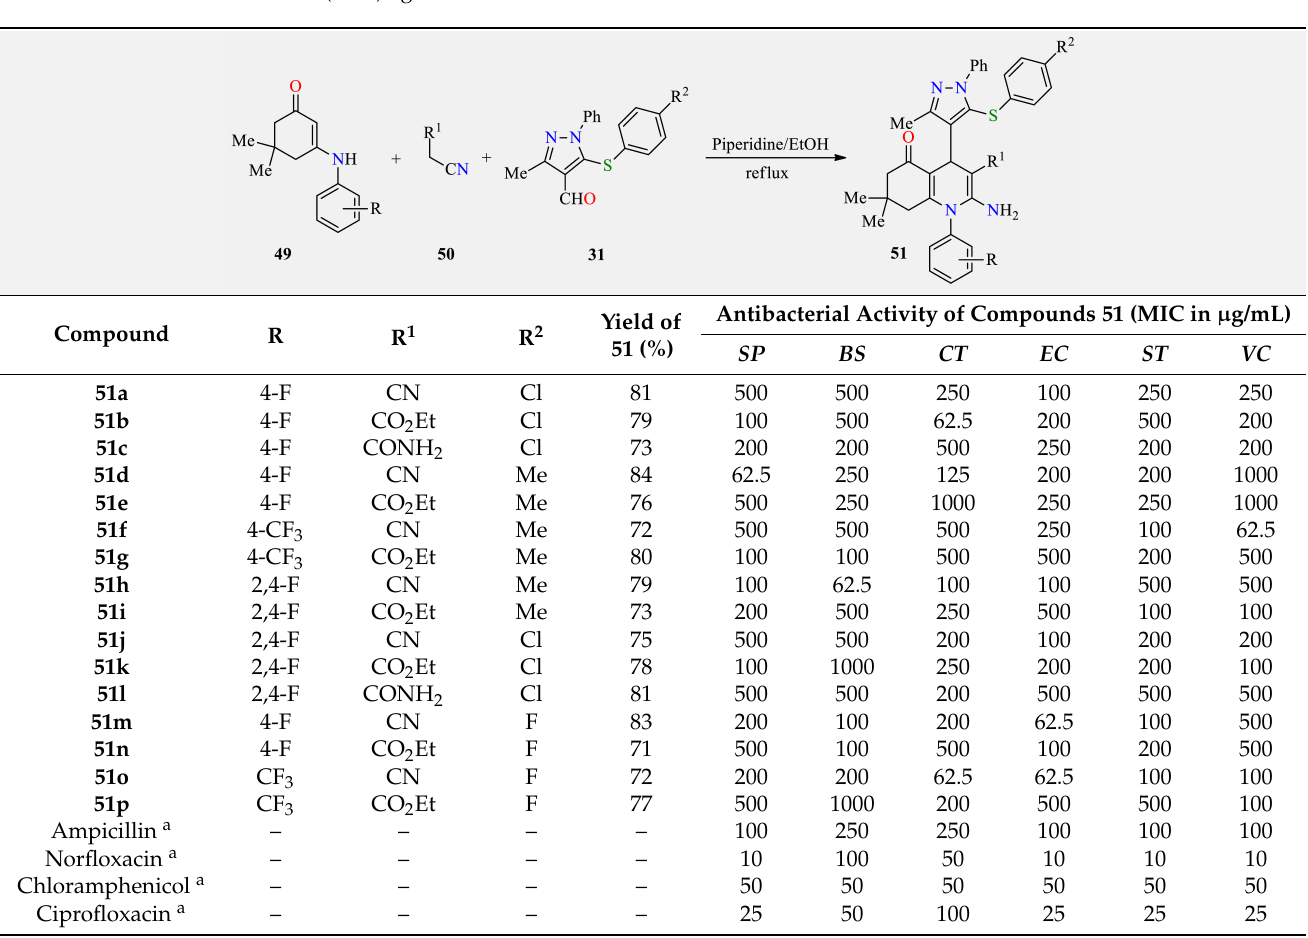
Table 13. Three-component synthesis of pyrazolo-quinolines 51 and their in vitro antibacterial activity (MIC) against six bacterial